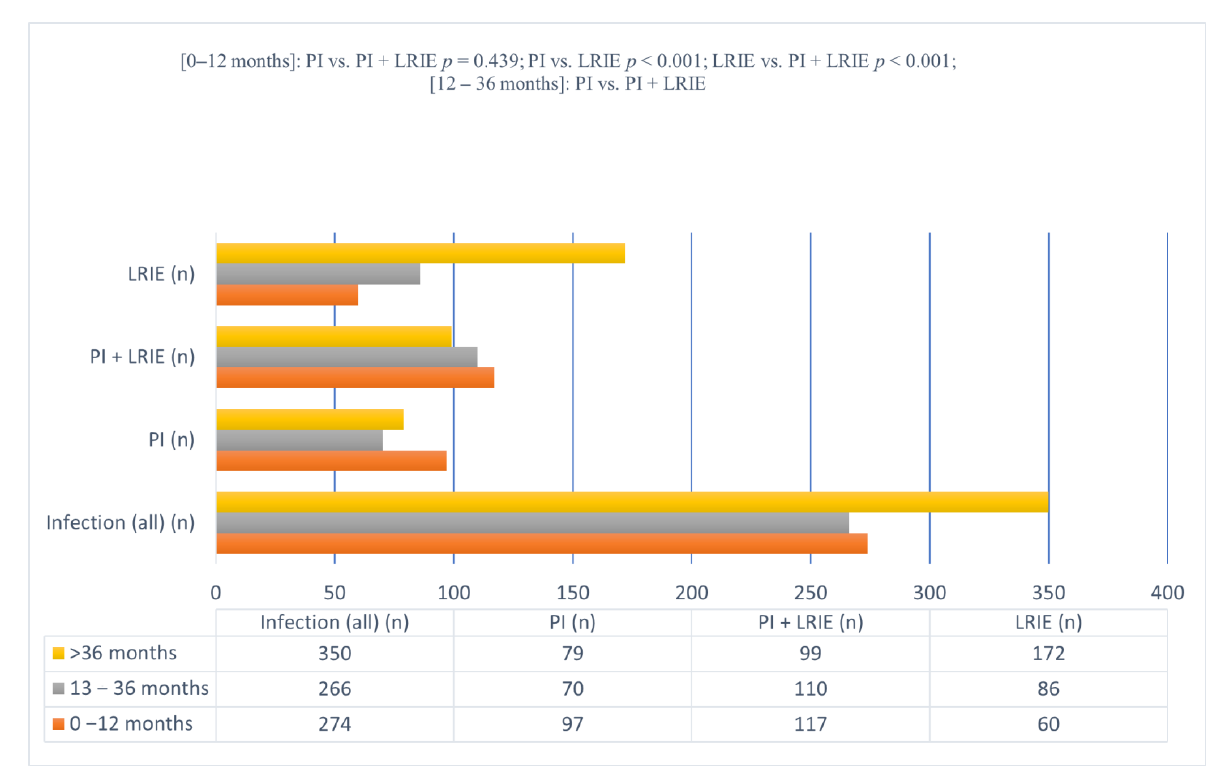
Figure 1. Prevalence of CIED infections at each time interval after a CIED-related procedure for noninfectious indications.